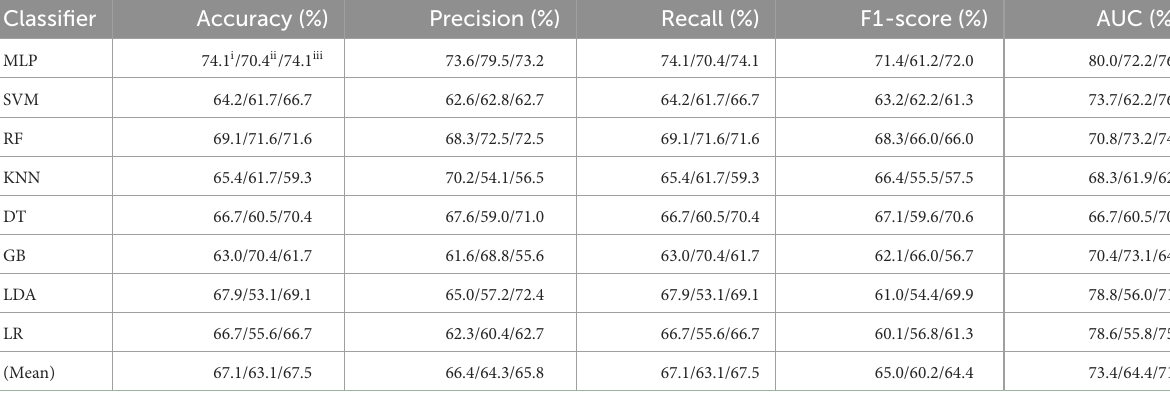
TABLE 5 Evaluation metrics of the different classifiers with three fused features (Experiment 3) on the test set, respectively.